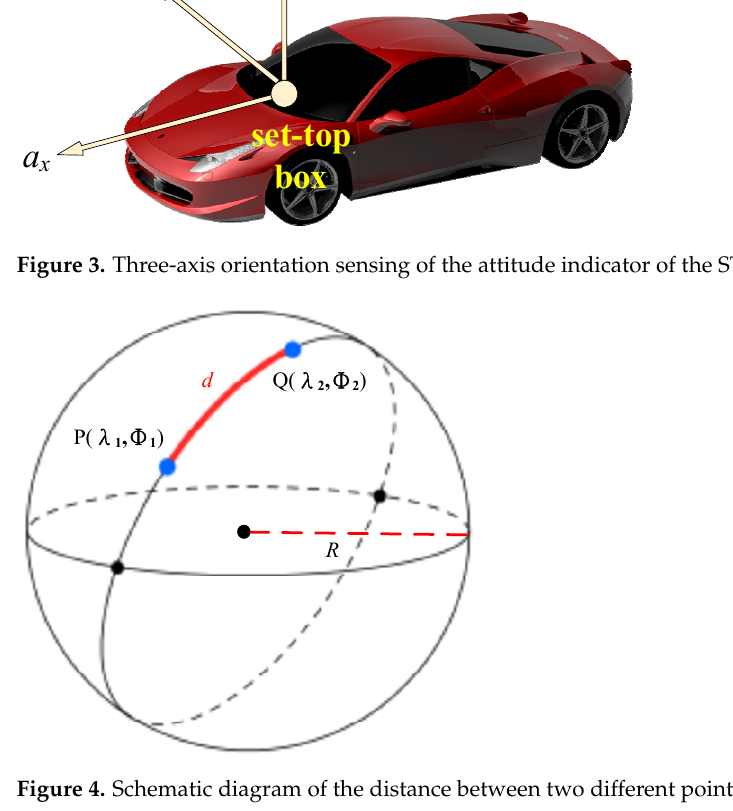
Figure 4. Schematic diagram of the distance between two different points in spherical coordinates.